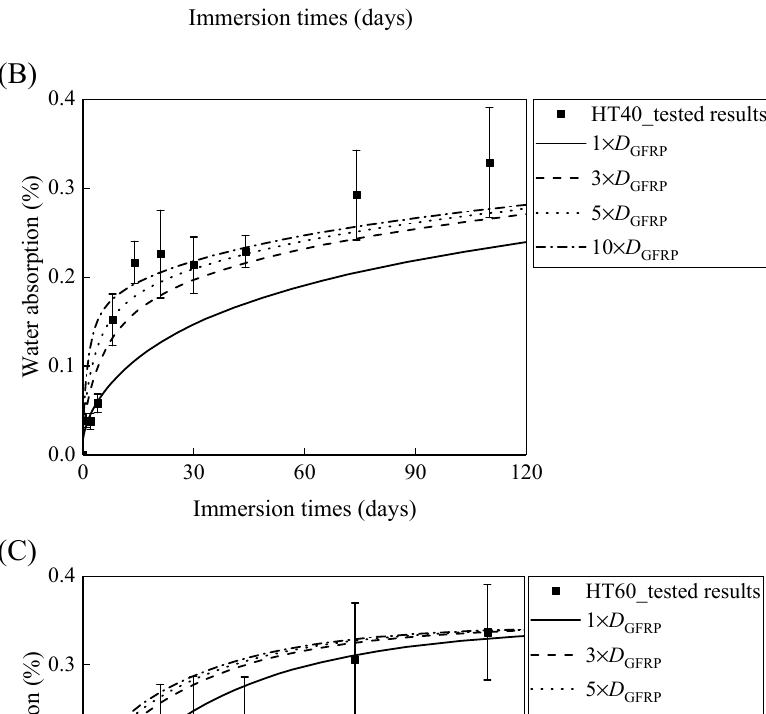
Table 2. The radial diffusivity coefficient of the carbon fiber coat calculated at various temperatures.